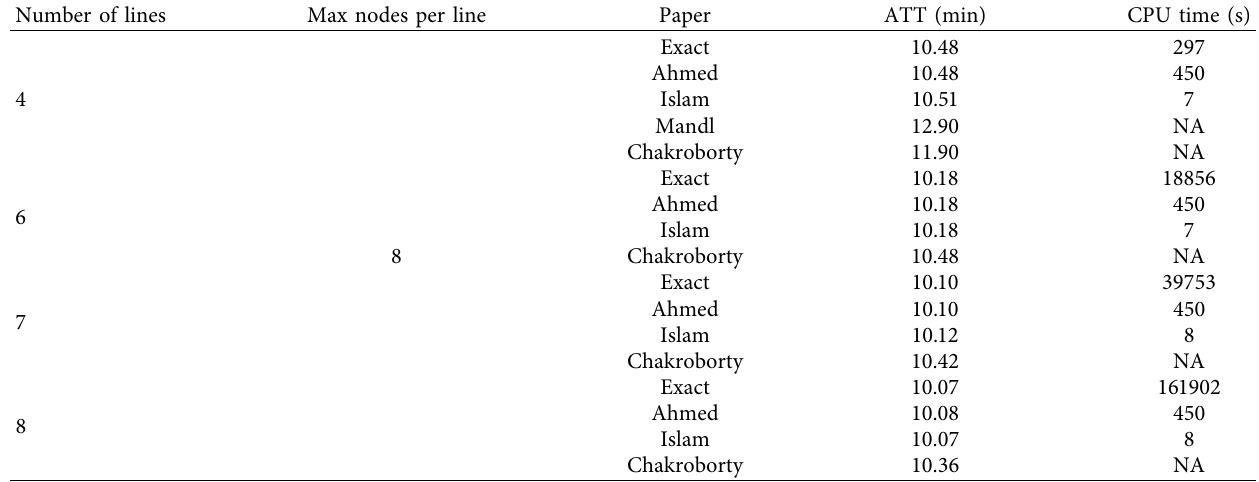
Table 5: Comparison of the exact algorithm with literature for at most 8 nodes per line.